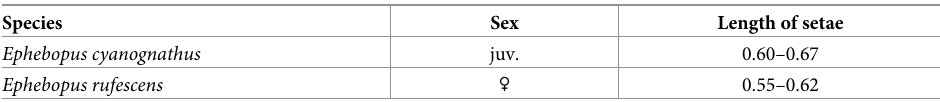
Table 12. Length ranges of type V setae. juv. = juvenile specimen.